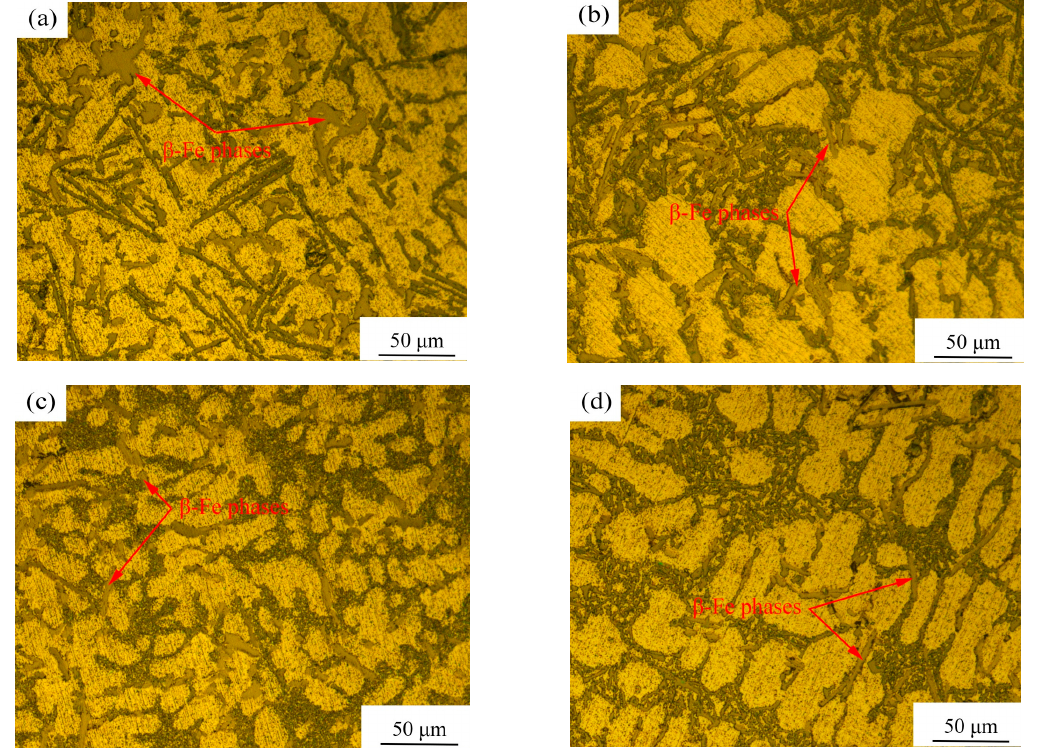
Figure 5. Effects of rare earth Yb addition on the iron-rich phases in as-cast ADC12 alloys: ( a ) unmodified; ( b ) 0.4 wt % Yb; ( c ) 0.8 wt % Yb; ( d ) 1.2 wt % Yb.